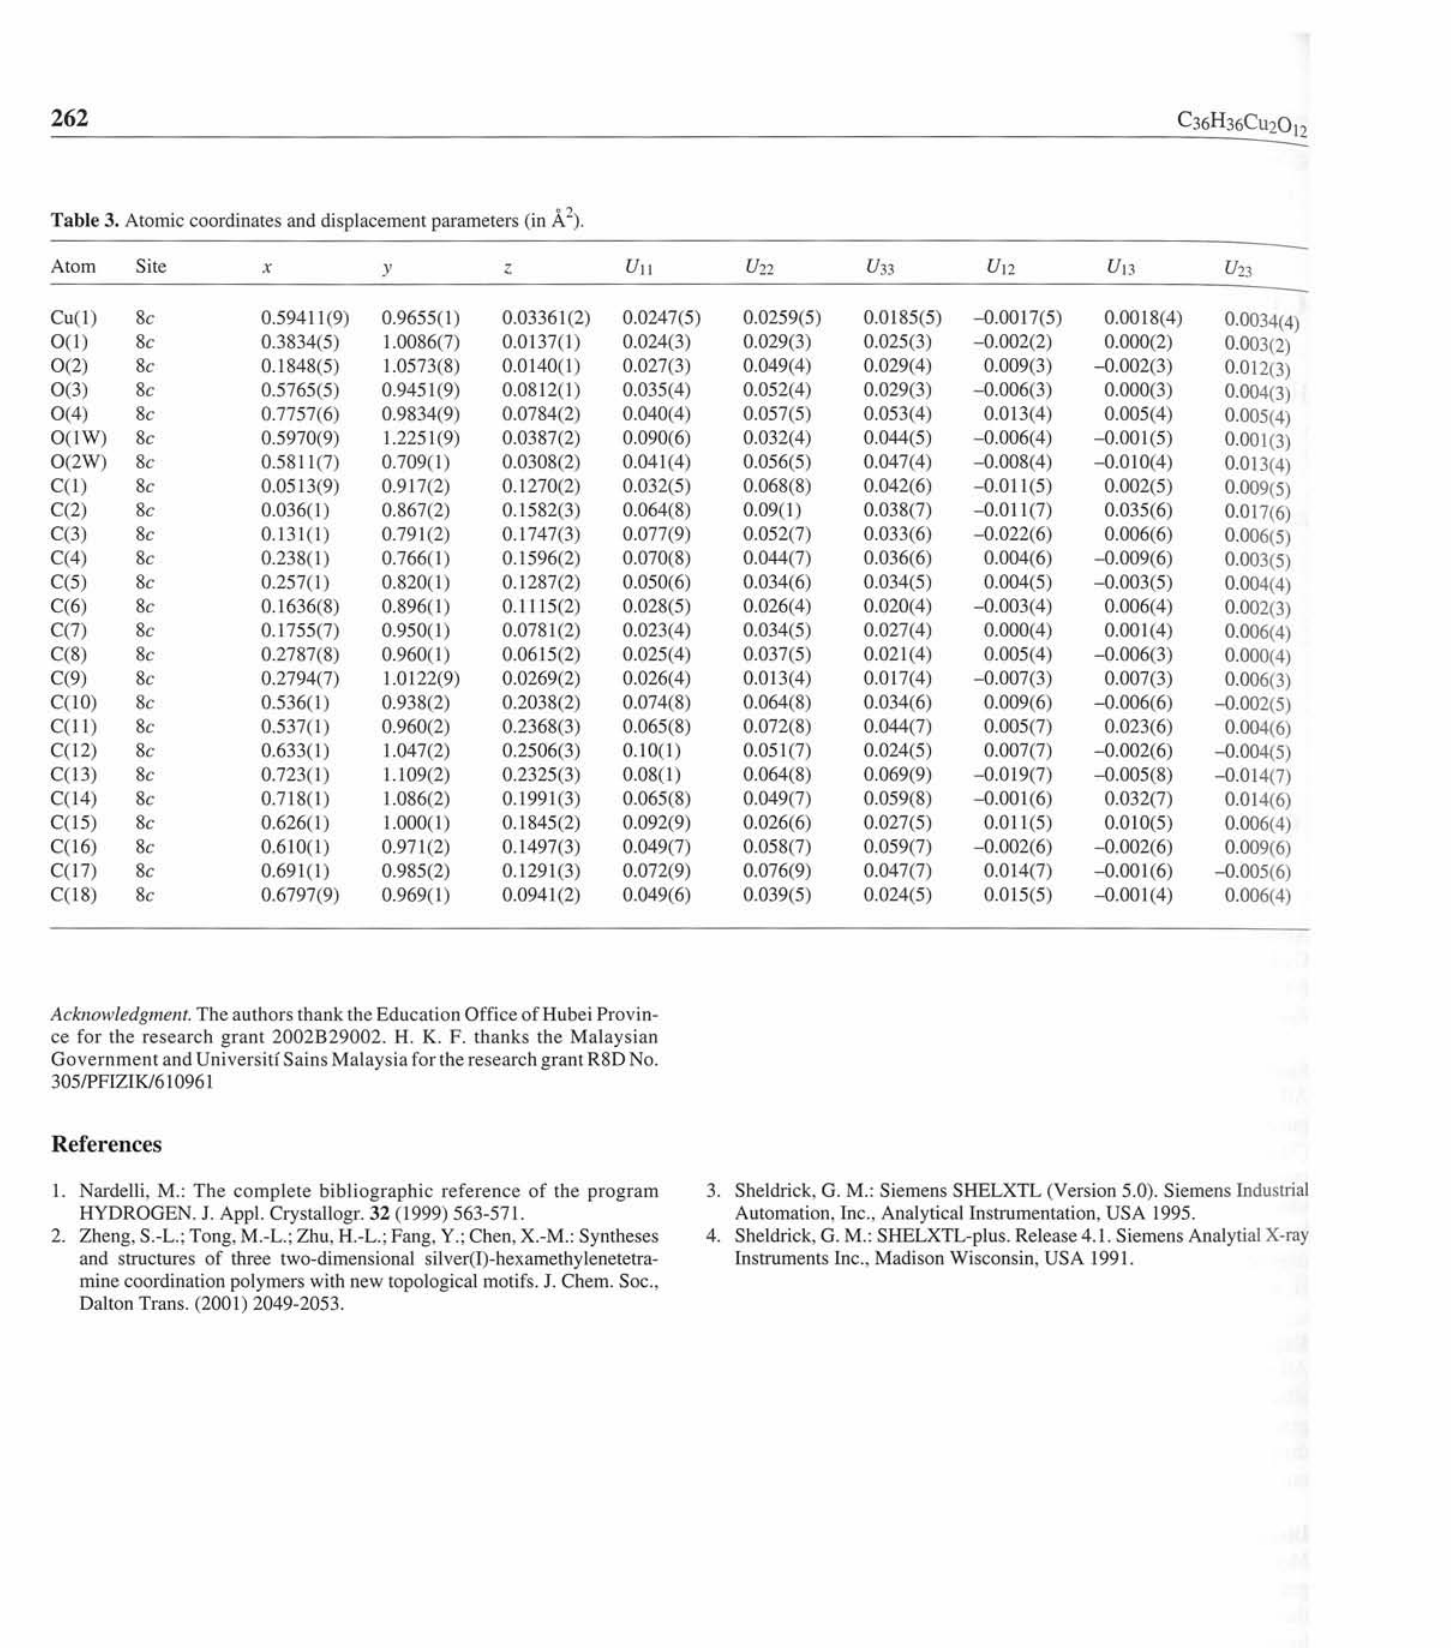
Table 3. Atomic coordinates and displacement parameters (in Â 2